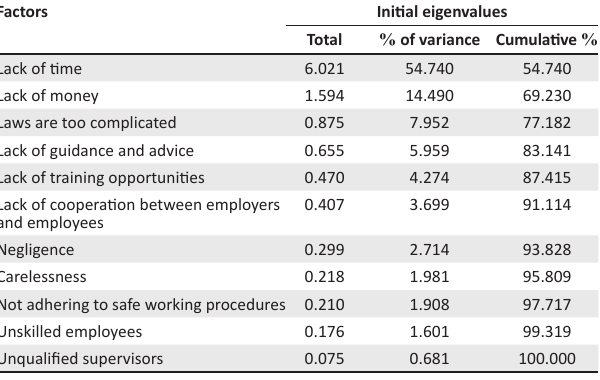
TABLE 4: Table of total variance explained.